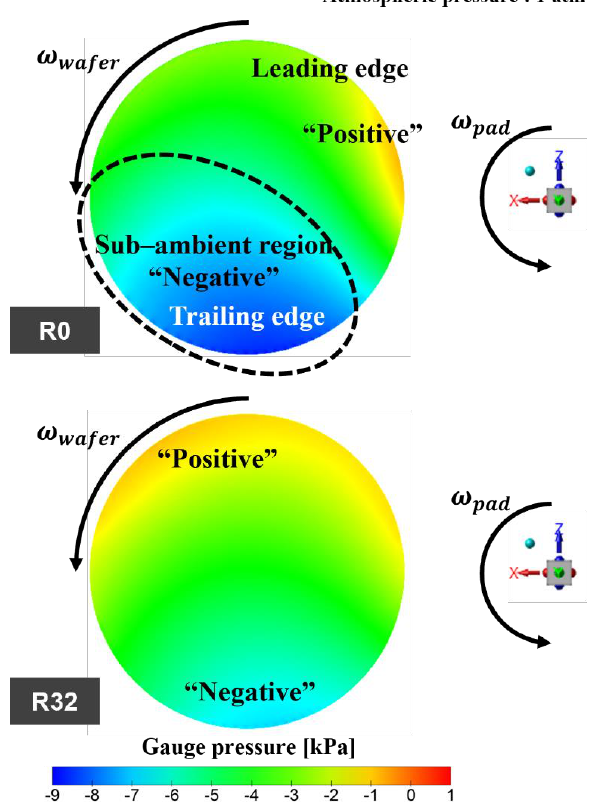
Figure 9. The gauge pressure field distribution at the wafer – pad interface.